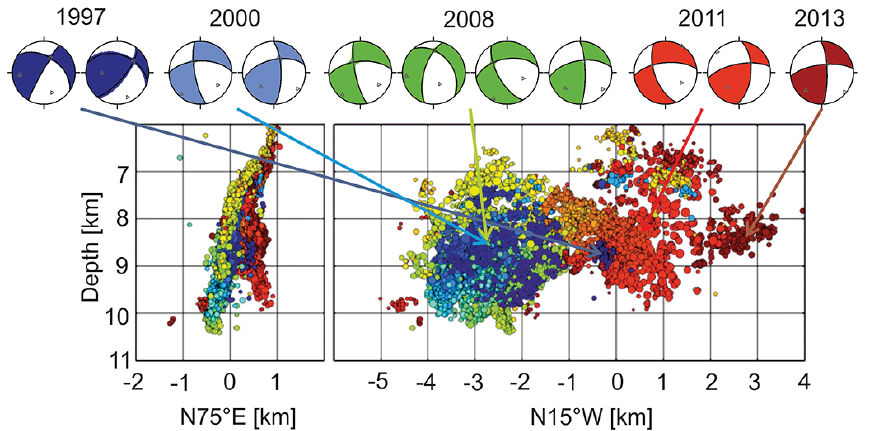
Figure 2. Two perpendicular profile depth sections of the Nový Kostel swarm hypocenters (circles) of swarms 1997 (dark blue), 2000 (blue), 2008 (yellow-green), 2011 (orange-red) and 2013 (dark red). Typical focal solutions are selected for the major swarms. Events are plotted for magnitude larger than 0.5; circle size refers to magnitude. The largest recorded event with magnitude M L 3.8 occurred in the swarm